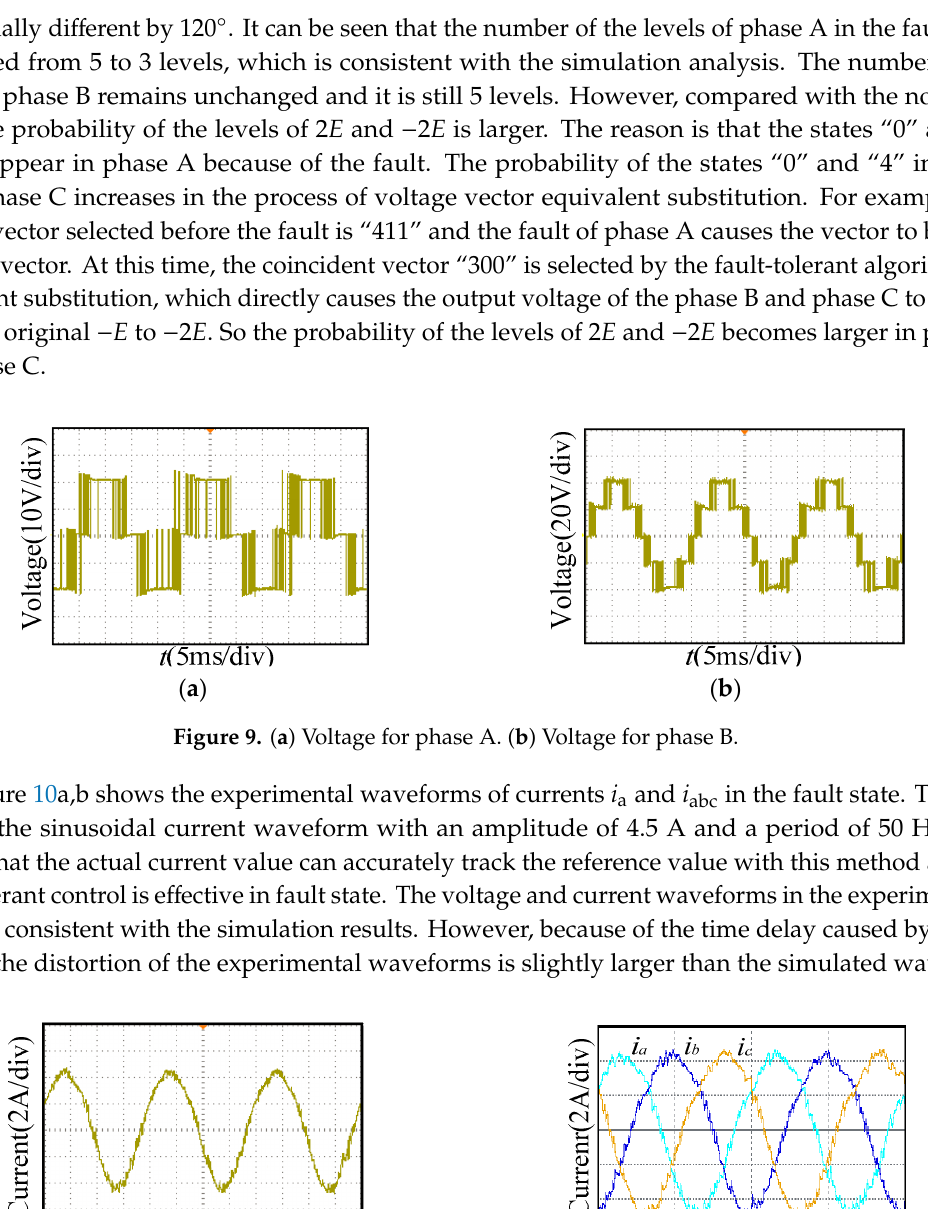
Figure 8. ( a ) Voltage for phase A. ( b ) Current for phase A.